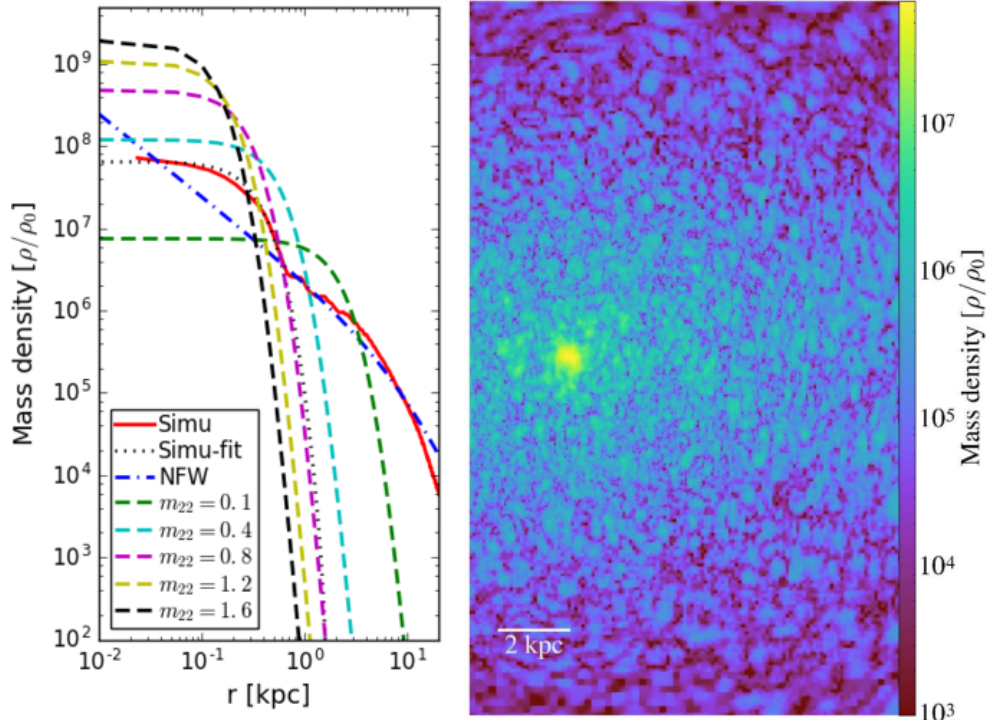
Figure 22. Dark-matter halos in the FDM scenario. Left panel: dependence of the dark-matter density profile on the mass of the boson compared with the NFW profile. Here m 22 is the boson mass in unit of 10 − 22 eV. Right panel: an image displaying the soliton in the center of a galaxy with an interference pattern surrounding it. The figure is reproduced from